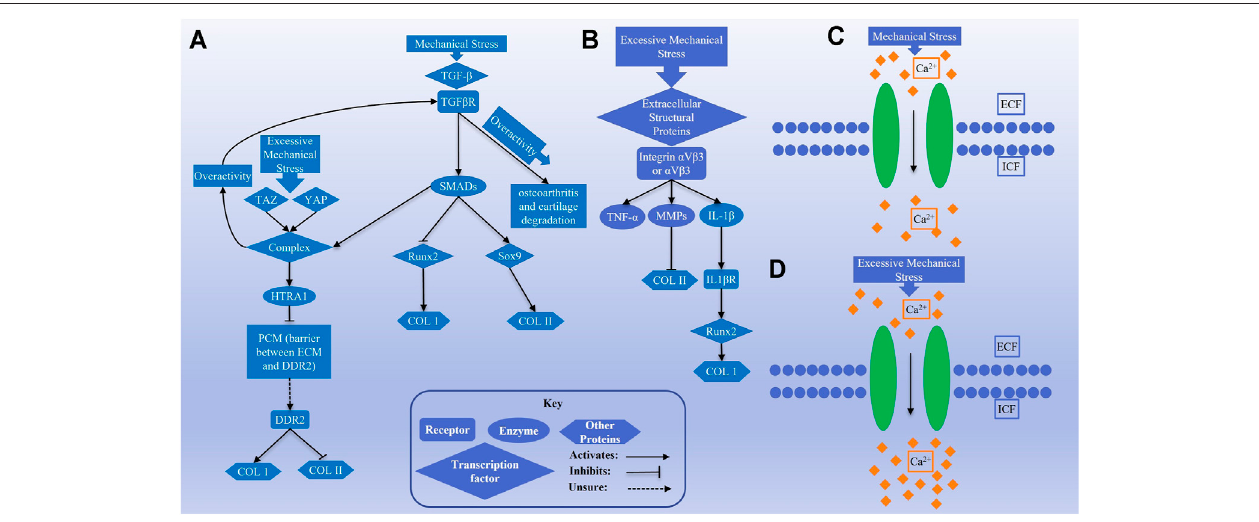
FIGURE 2 | Schematics (A) and (B) show transforming growth factor- β (TGF- β ) and α V integrin signaling pathways, respectively, activated by mechanical stimulation. Schematics (C) and (D) represent the activity of calcium channels by normal and excessive mechanical stress in chondrocytes.